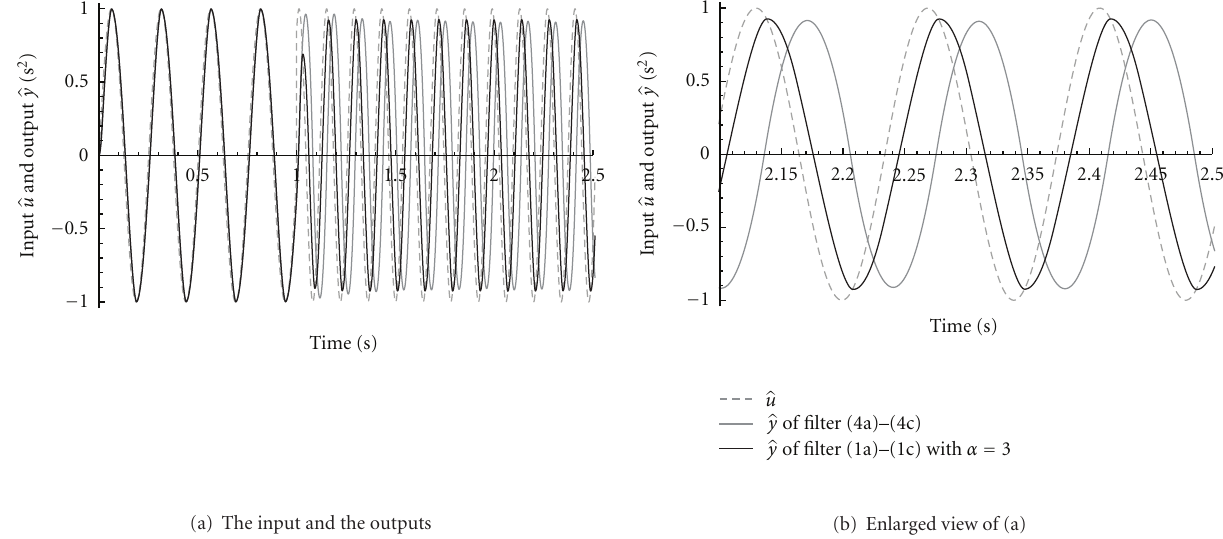
Figure 6: Comparison between filter (1a)–(1c) and filter (4a)–(4c) in the case where the normalized input suddenly changes from (cid:8) u = 0 . 00067sin(25 t )s 2 to (cid:8) u = 0 . 00067sin(45 t )s 2 at t = 1s.